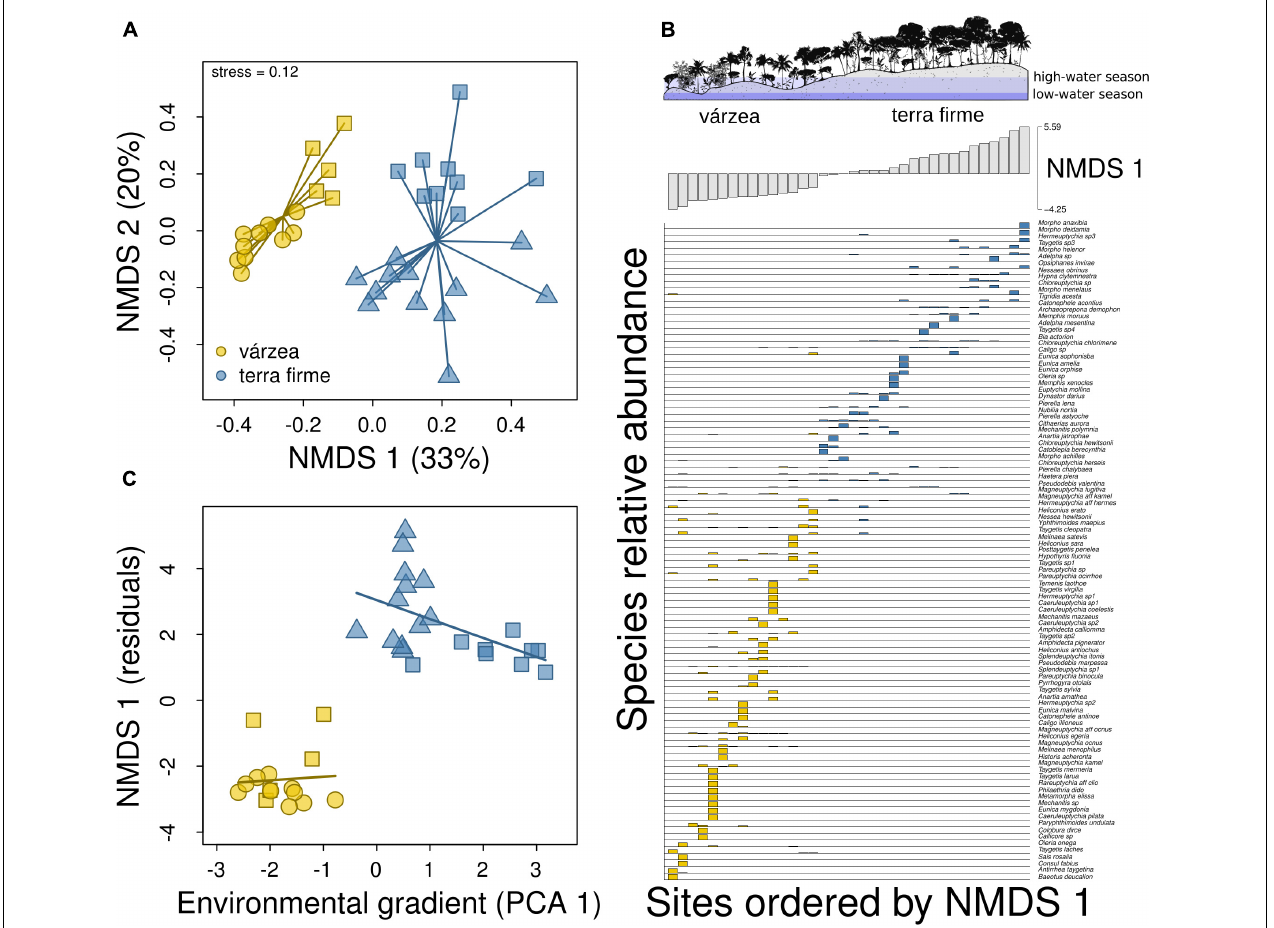
FIGURE 4 | Changes in species composition between várzea and terra firme forests. (A) Butterfly species composition in a bi-plot with the two axes derived from a NMDS ordination. Each point in the graph represents a plot located in várzea or terra firme forest and the distance between points represents the similarity of plots in terms of their species composition. Square, circle, and triangle symbols represent plots in Baixo Juruá, Mamirauá, and Amanã reserves, respectively. (B) Distribution of butterflies across sample sites. Sample sites are ordered by a single NMDS axis and bar heights show the relative abundance of butterfly species across várzea (gray) and terra firme (black) plots. (C) Change in species composition (NMDS 1) with environmental gradients (PCA 1) along and within each forest type, after controlling for the effects of latitude and